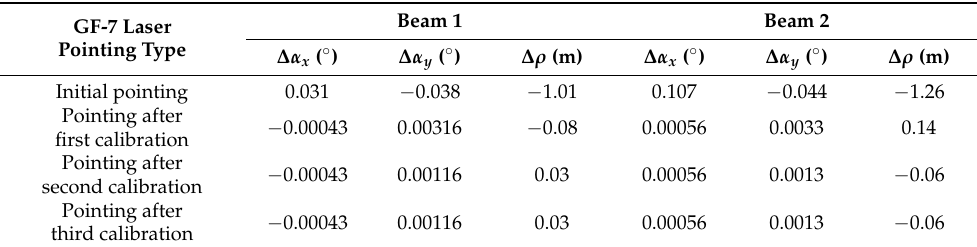
Table 3. Laser pointing and ranging accuracy before and after three iterative calibrations based on